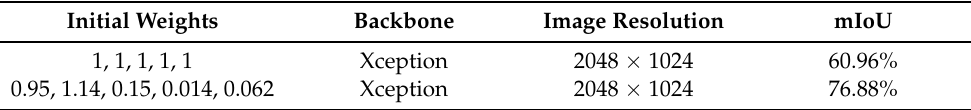
Table 3. Comparison of training results with different initial